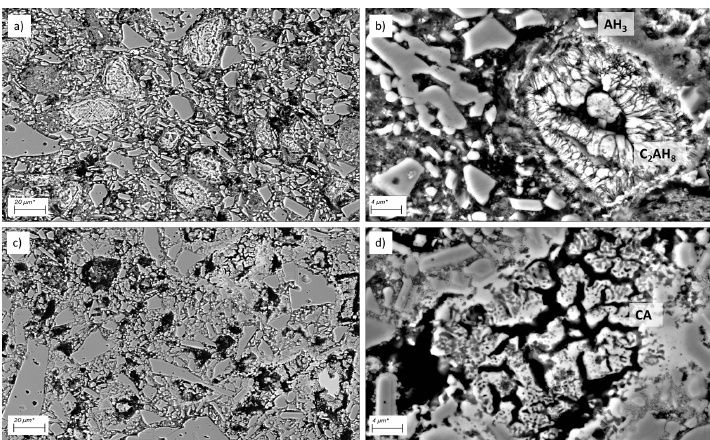
Figure 7. SEM images of ( a , b ) concrete sample before sintering and ( c , d ) concrete sample after sintering emitter.